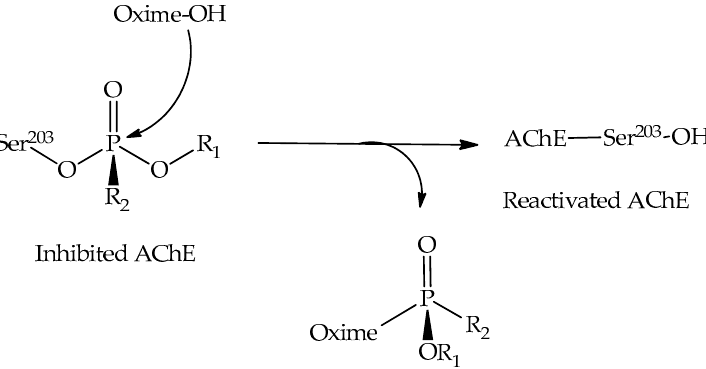
Figure 1. General representation of the reactivation process of the inhibited acetylcholinesterase (AChE).